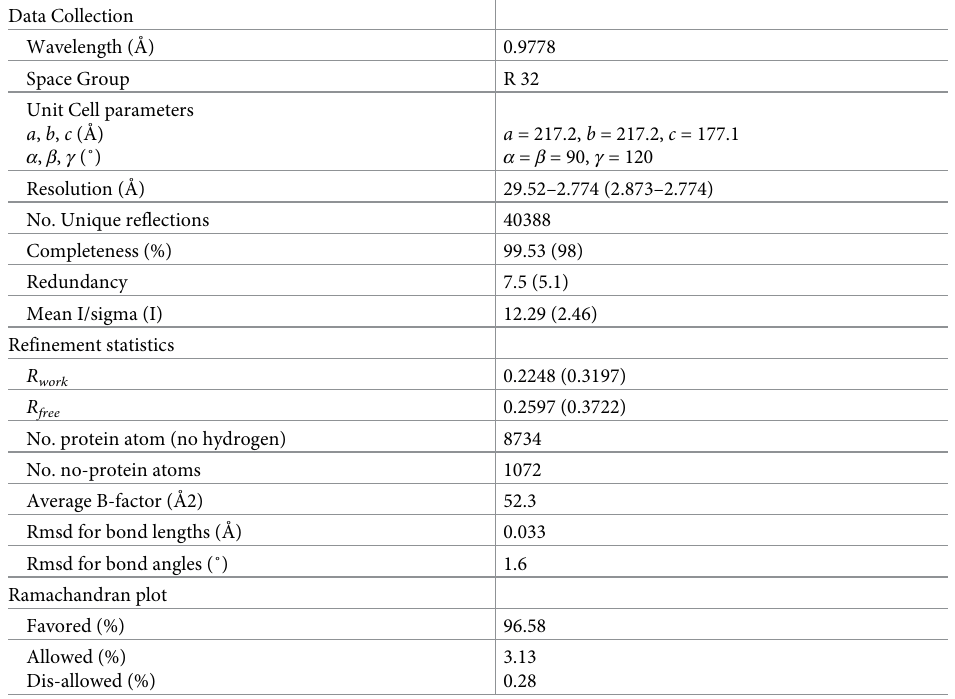
Table 1. Statistics on qualities of diffraction data set, phasing and refined atomic